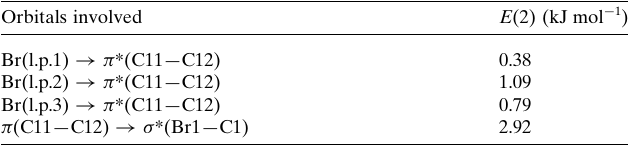
Table 3 Second-order perturbation energy E (2) for the Br (cid:2)(cid:2)(cid:2) (cid:3) interaction. Orbitals involved E (2) (kJ mol (cid:4) 1 ) Br(l.p.1) ! (cid:3) *(C11—C12)